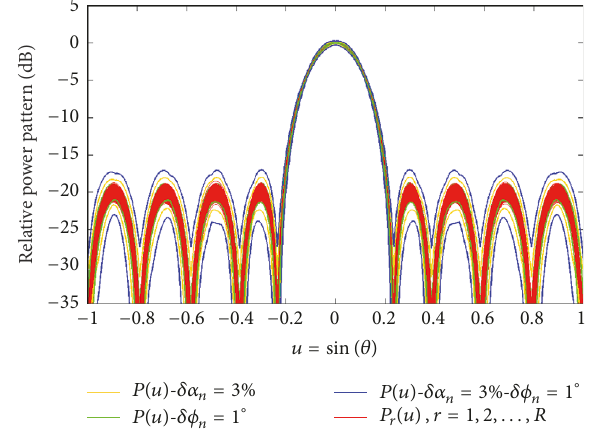
Figure 3: Bounds of the power pattern 𝑃(𝑢) based on IA with 𝛿𝛼 𝑛 = 3 %, 𝛿𝜑 = 1 ∘ . 𝑛